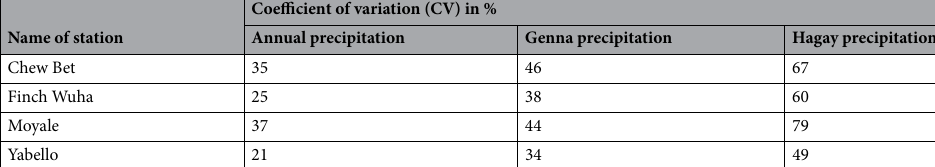
Table 2. Annual and seasonal coefficients of variation (CV) in % for selected stations. Source (Author): Computed based on data from the NMA of Ethiopia.